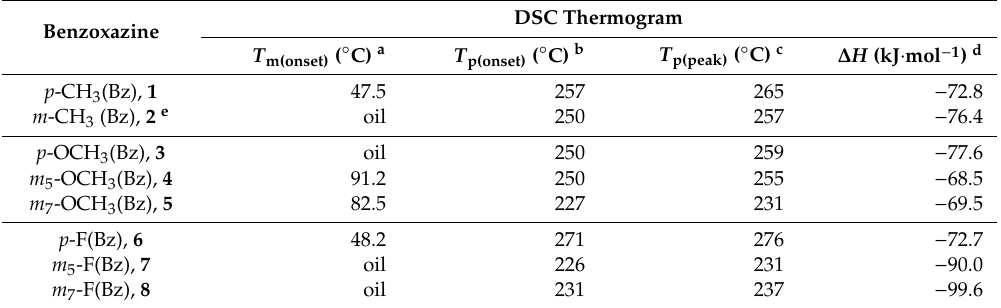
Table 1. Di ff erential scanning calorimetry (DSC) analysis of p - and m -substituted monobenzoxazines.